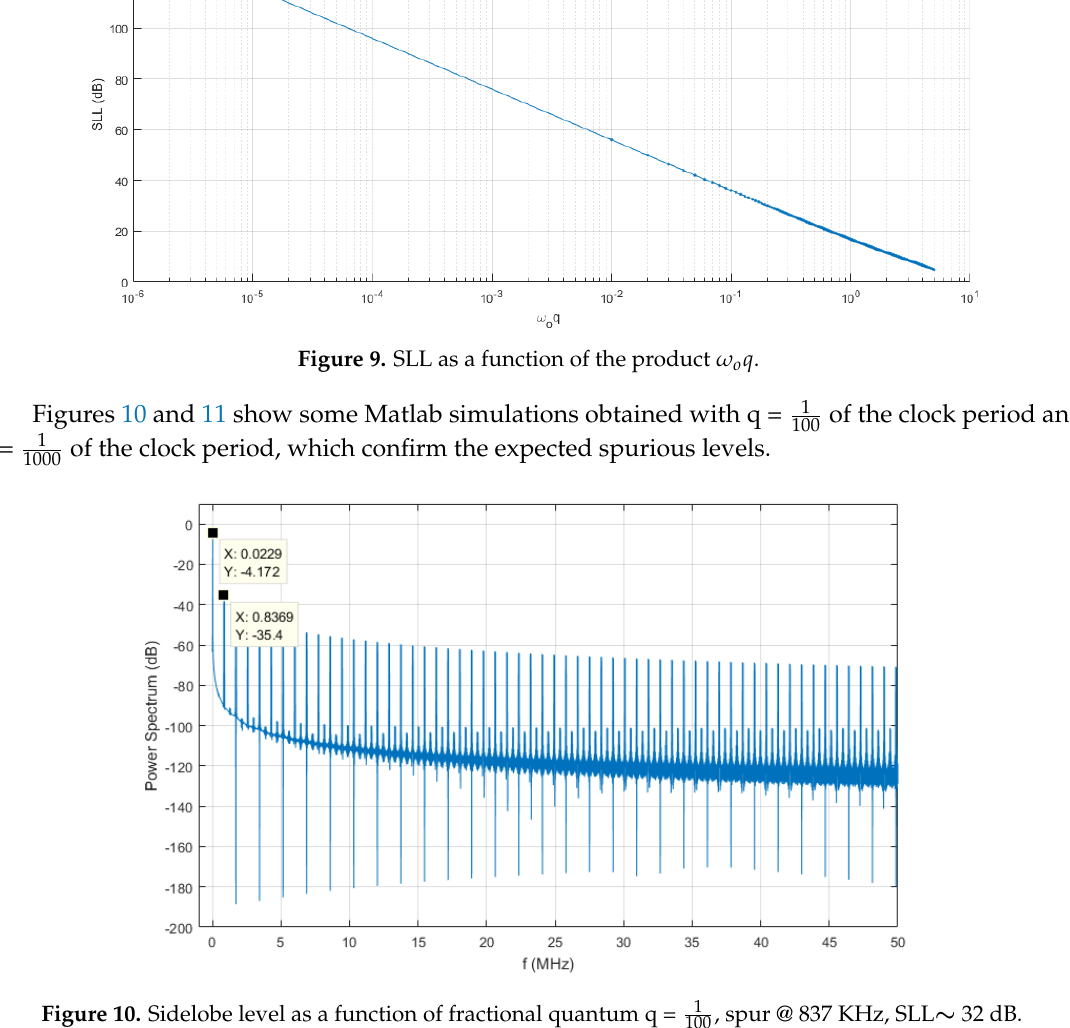
, spur @ 837 KHz, SLL ∼ 32 100